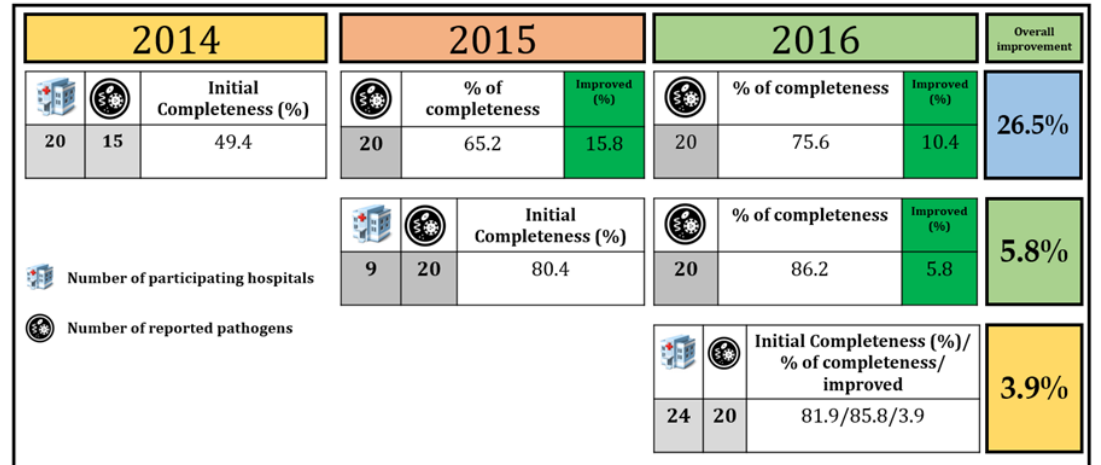
Figure 5. LOINC mapping performance comparison among 53 hospitals.